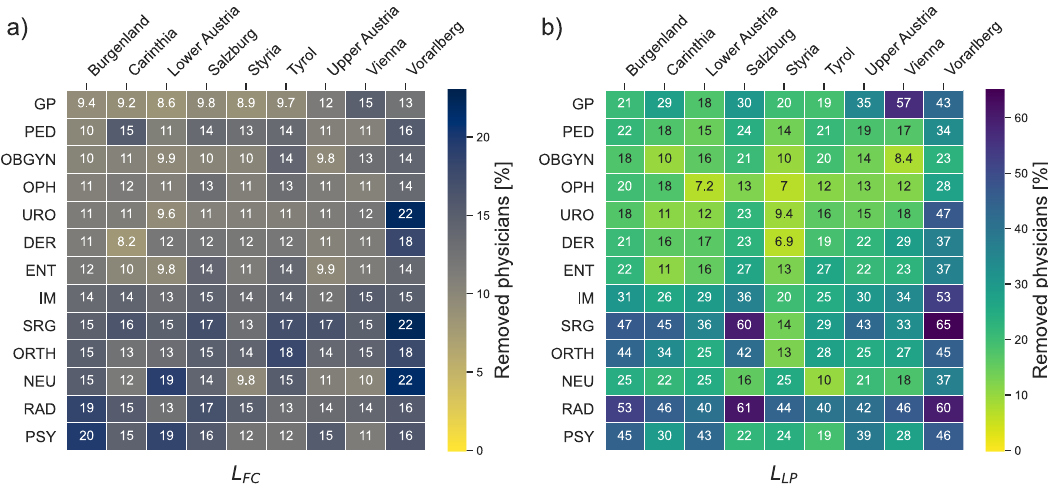
Fig. 3 Critical resilience limits. Average critical % of removals in federal states per specialty until limits of free capacity ( a ) and lost patients ( b ) are reached. Critical limits are 1% for lost patients and 20% for remaining free capacity. Darker colours indicate a higher number of physicians who can be removed before exceeding critical limits. Tables including the standard deviation of simulation results are given in Supplementary Tables 2 and 3. For a list of abbreviations of specialists see Table